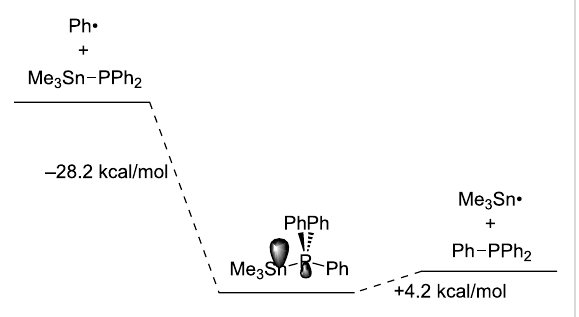
Figure 1: Calculated reaction profile of homolytic substitution between Ph• and Me 3 Sn–PPh 2 at the B2-PLYP-D/TZVVP//PBE-D/TZVP level. Gray lobes indicate major spin densities.